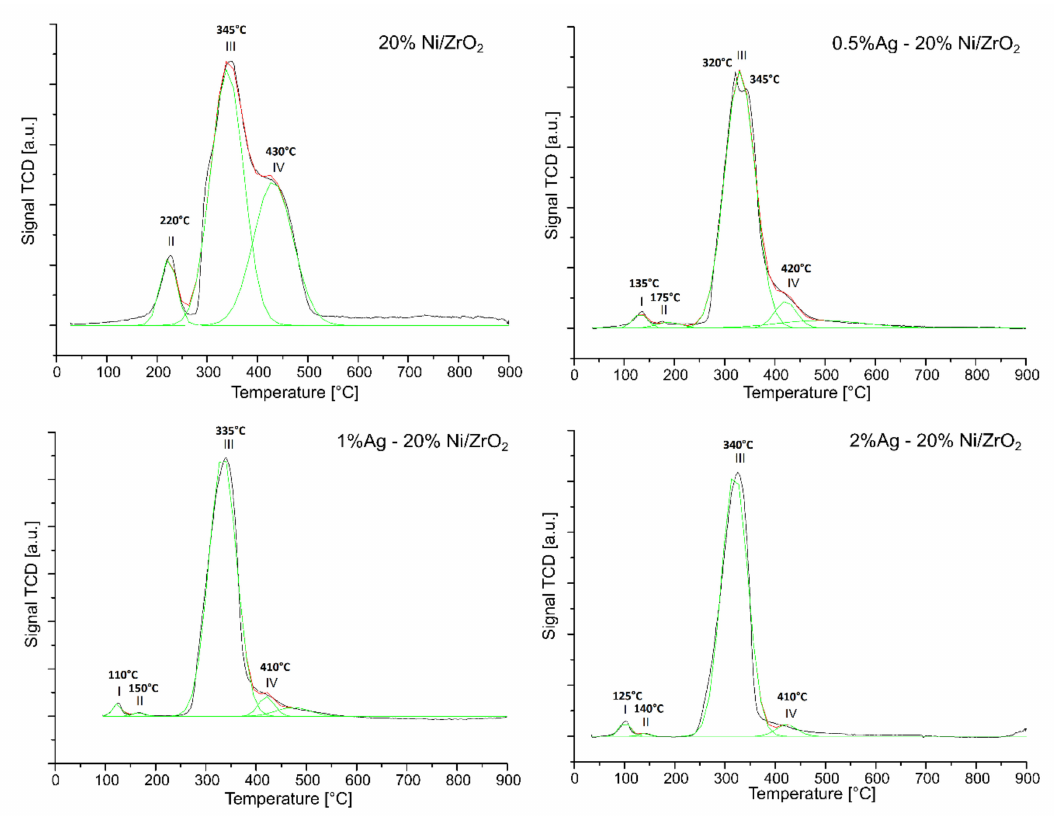
Figure 7. TPR profiles of mono- and bimetallic catalysts calcined at 400 ◦ C in an air atmosphere for 4